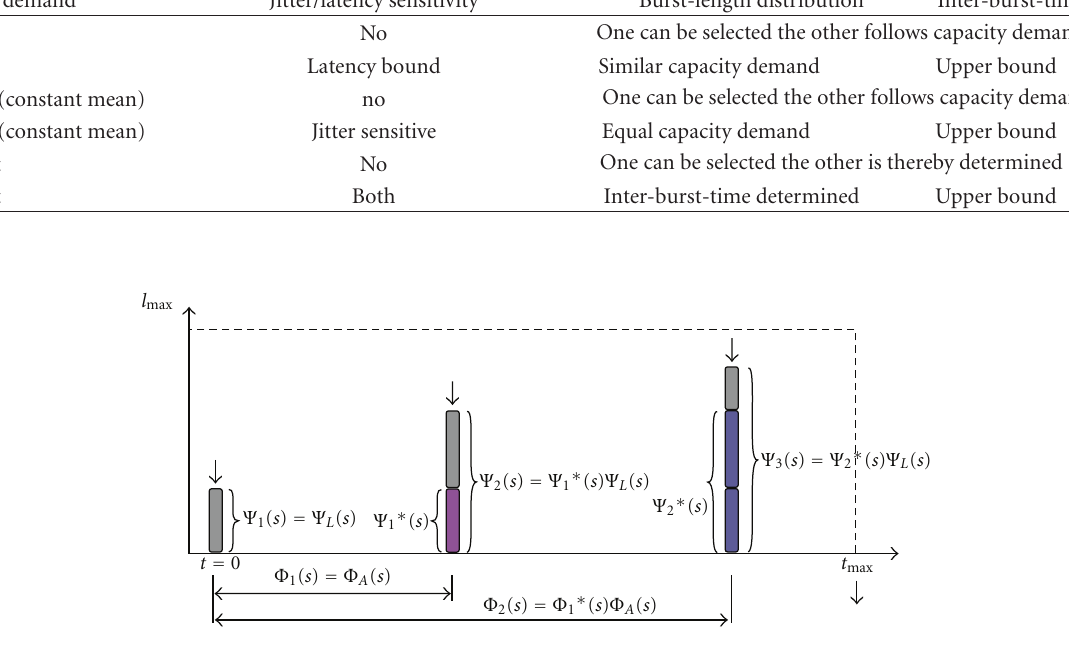
Figure 6: Hybrid burst assembly: length and time delimited.